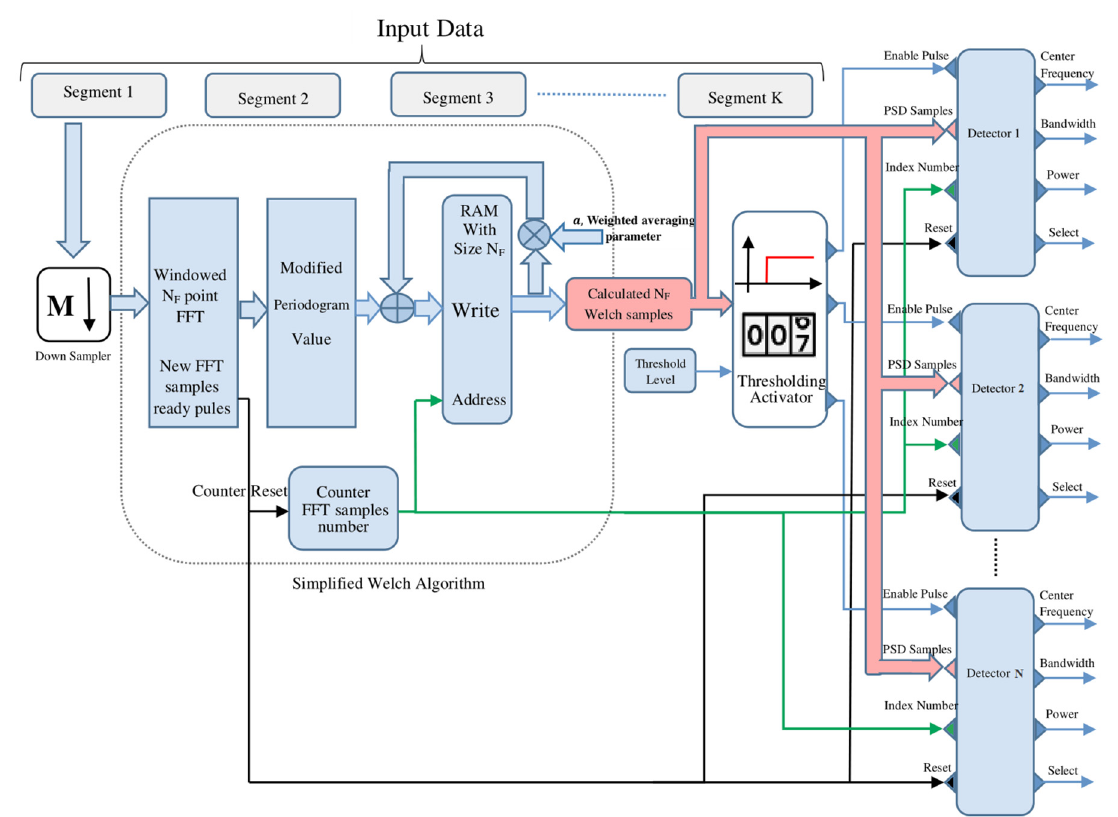
Figure 4. Proposed multi-narrowband detector with details.